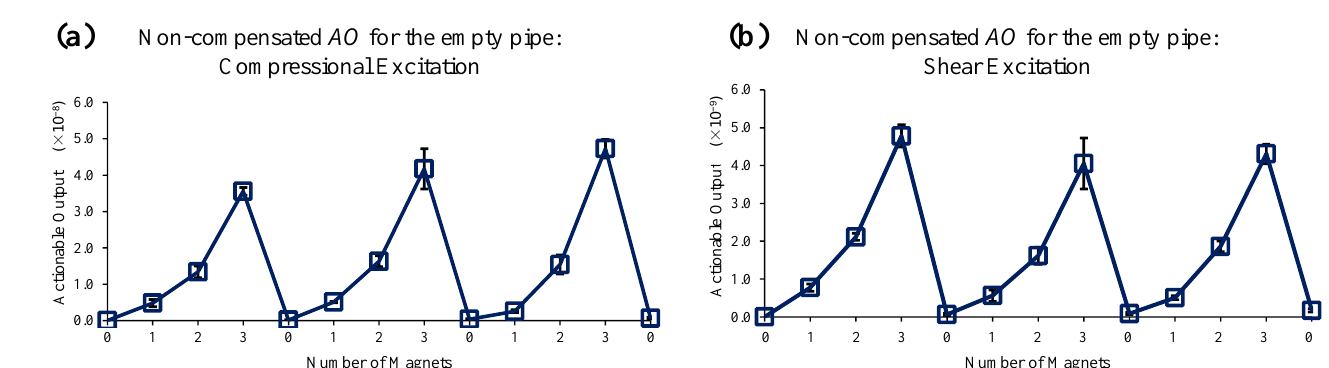
Figure 8. Changes in AO with the different number of magnet perturbations: the empty pipe with ( a ) compressional and ( b ) shear excitations. Simple time and frequency filtering lead to improved detection.